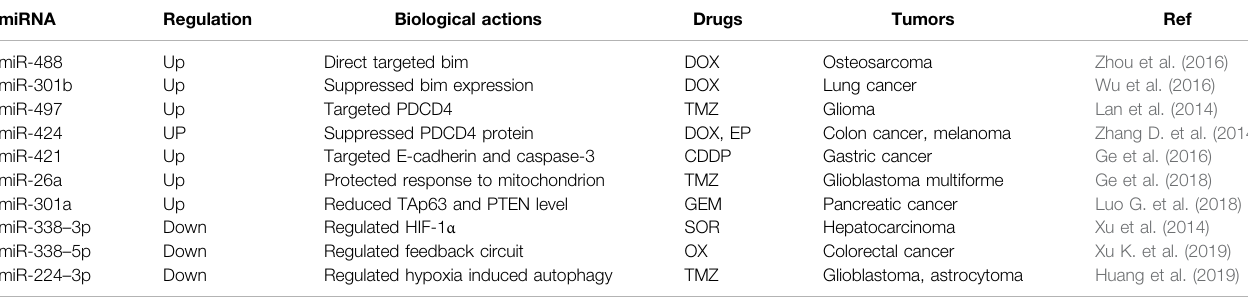
TABLE 2 | Hypoxic TME regulates miRNAs expression to induce CMT resistance.